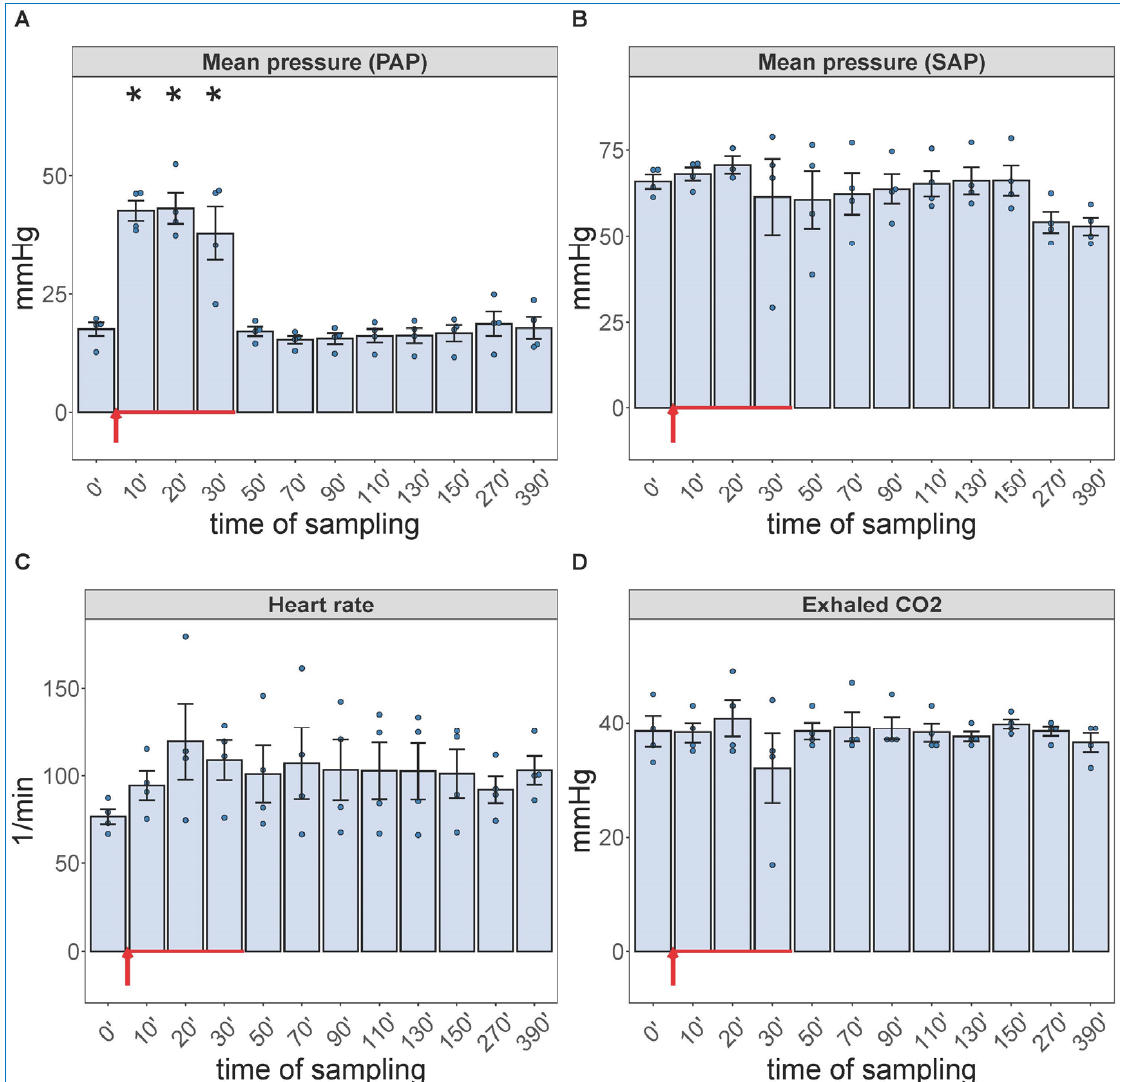
Figure 2. Physiological changes caused by infusion of 1.0 mg/kg zymosan in pigs. PAP ( A ), SAP ( B ), HR ( C ) and exhaled CO 2 ( D ) were continuously recorded up to 6.5 h, and the coinciding values at the indicated time points were averaged (±SEM) in four animals. Here, we show the blood pressure on absolute (mmHg) scale without the flat pre-injection background (Figure 1). The red arrow indicates zymosan administration. * p < 0.05 relative to respective baselines (0 min.), determined using paired t -test.